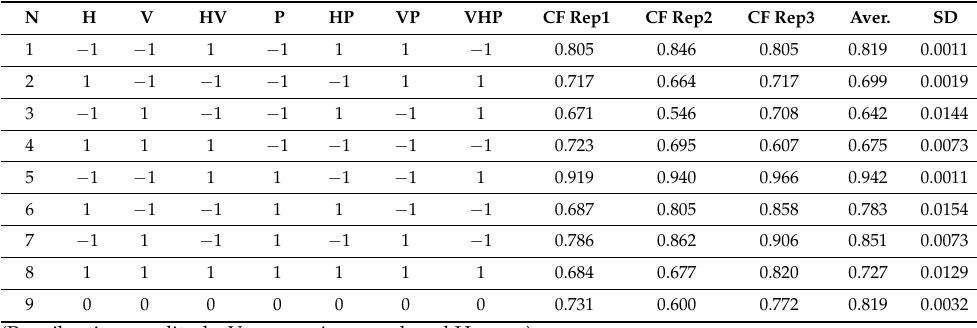
Table 4. Absolute reflectance after cleaning [%] for slightly soiled mirrors.